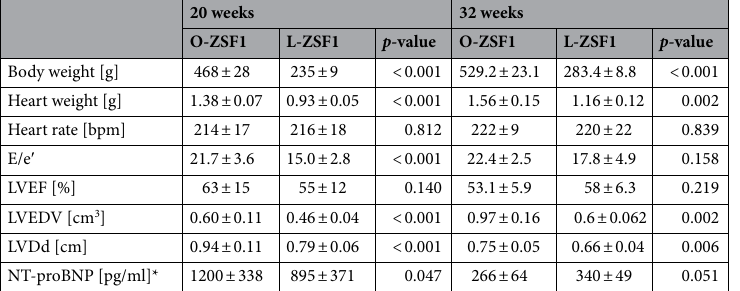
Table 1. Characteristics of O-ZSF1 and L-ZSF1 rats at 20 and 32 weeks of age. Mean and standard deviation are shown; p -value was calculated using Student’s t-test. Bpm (beats per minute), E/e ′ (ratio of mitral peak velocity of early filling (E) to early diastolic mitral annular velocity (e ′ )), LVEF (left ventricular ejection fraction), LVEDV (left ventricular end-diastolic volume), LVDd (left ventricular diastolic diameter), NT-proBNP (N terminal B natriuretic peptide). *Due to different manufacturers, the results at 20 and 32 weeks are not directly